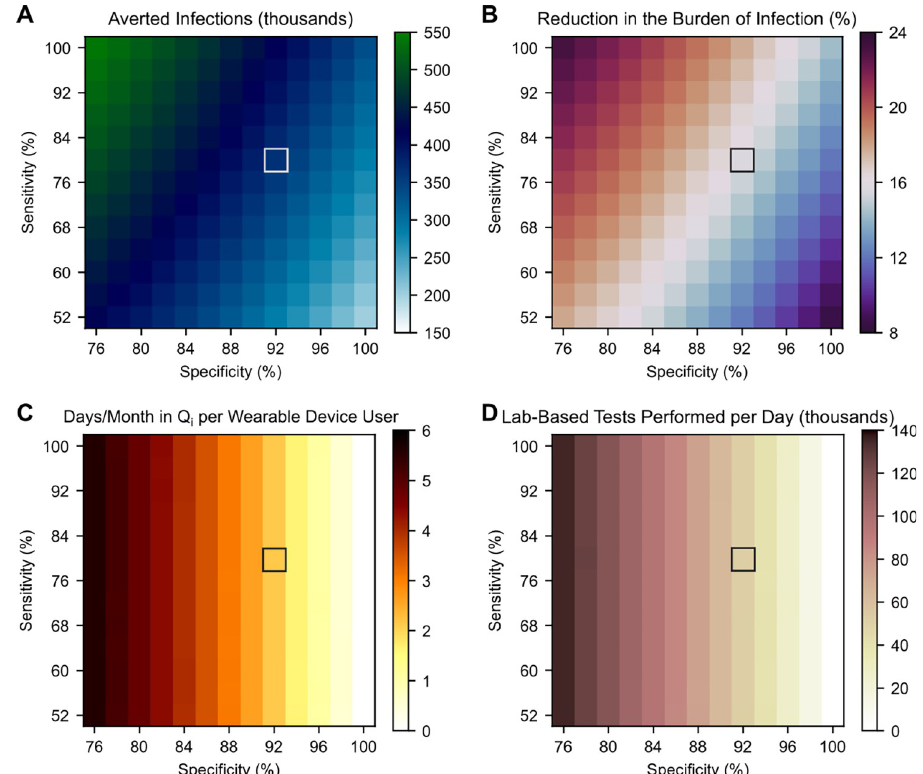
Fig 3. Tradeoff between detection sensitivity and specificity. (A) Averted infections, (B) reduction in the burden of infection, (C) days incorrectly spent in quarantine per month per user, and (D) average daily demand for lab-based tests, all over the simulation period, as a function of detection sensitivity and specificity. Grey boxes denote nominal sensitivity (80%) and specificity (92%).